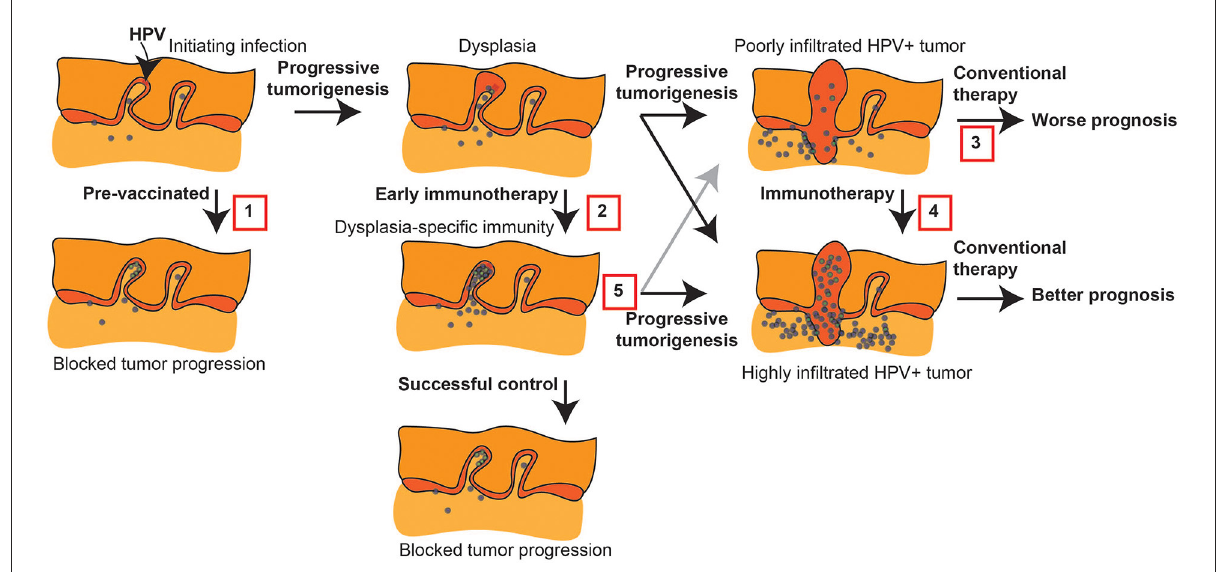
FIGURE1 Immune intervention during tumorigenesis and prior to conventional therapy. HPV + tumorigenesis provides a model to show potential interventions prior to conventional therapy for HNSCC that can impact outcome. 1. Protective HPV vaccination can prevent the initial transformation that can result from HPV infection. 2. Early immunotherapy of dysplasia can enhance HPV-specific responses or direct new immune responses to genes involved in progression to prevent further progression. 3. Malignant tumors can have a poor pre-existing immune response that is associated with poor prognosis following conventional therapy. 4. Immunotherapy can convert the tumor environment by directing immune responses to the tumor, and this has the potential to convert patients to an improved prognosis. 5. Even where early immunotherapy fails to prevent tumorigenesis, it may result in a tumor with a strong-pre-existing immune response that would be predicted to have a better prognosis following conventional